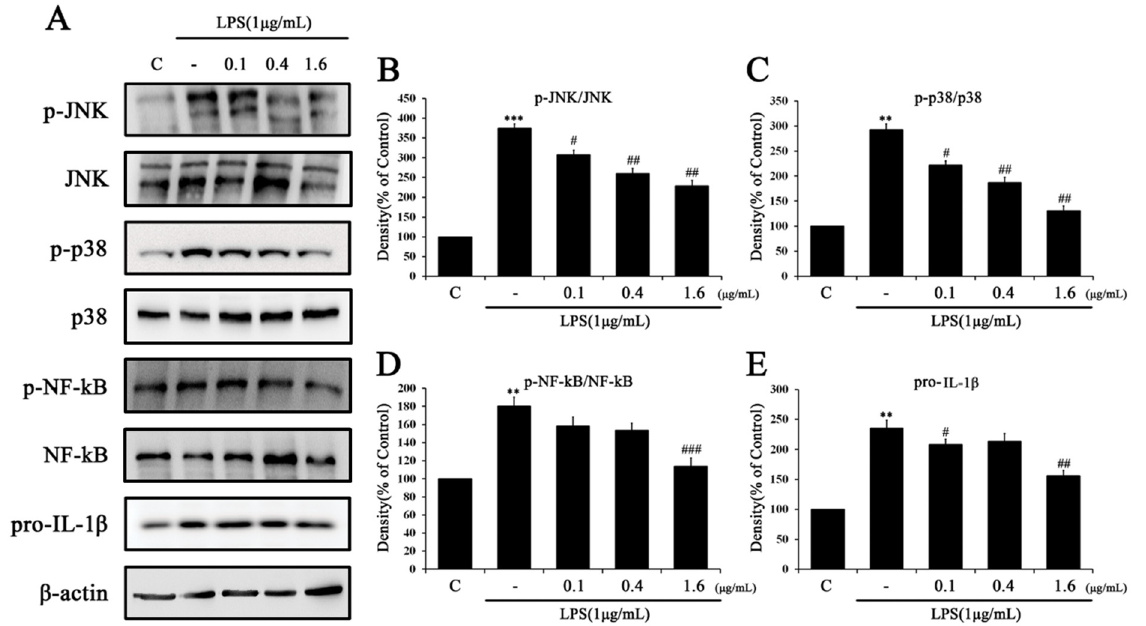
Figure 4. Effects of T β 4 on the NF ‐κ B pathway in LPS ‐ induced RAW 264.7 cells. RAW 264.7 cells were pretreated with T β 4 (0.1, 0.4, and 1.6 μ g/mL) for 1 h, followed by NLRP3 priming using LPS (1 μ g/mL) for 4 h. ( A ) The expression of (p) ‐ JNK, (p) ‐ p38, (p) ‐ NF ‐ kB, and pro ‐ IL ‐ 1 β was assessed by western blotting. ( B – E ) The bar graph represents the mean of A. The intensity of the control band was set to 100%, and the relative intensities of all other bands were calculated. Data are presented as mean ± SEM (n = 3). ** p < 0.01 compared with the control. *** p < 0.001 compared with the control. # p < 0.05 compared with the LPS ‐ treated group. ## p < 0.01 compared with the LPS ‐ treated group. ### p < 0.001 compared with the LPS ‐ treated group.